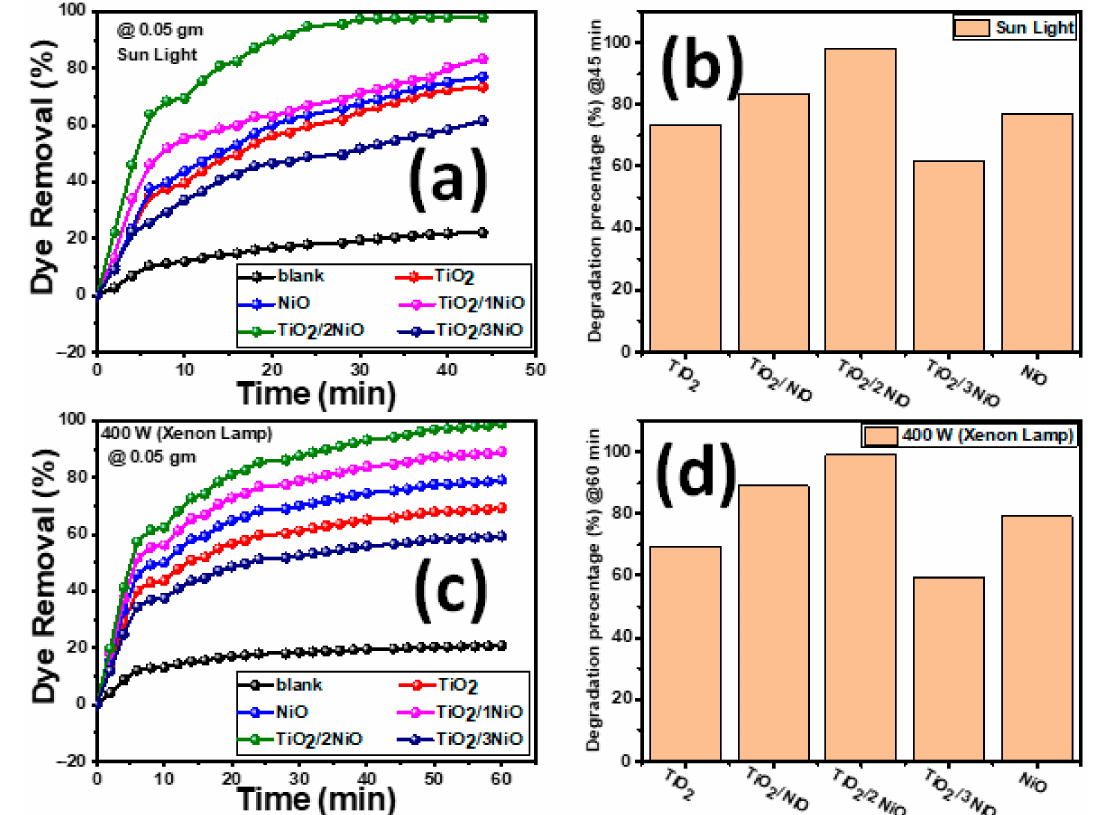
Figure 6. ( a ) The influence of sunlight illumination on the photodegradation of MB dye (5 mg/L) for all prepared nanopowder (0.05 g); ( b ) the degradation percentage of MB under sunlight irradiation for 45 min; ( c ) the effect of Xenon Lamp (400 W) irradiation on the photodegradation of MB dye (5 mg/L) for all fabricated nanopowder (0.05 g); and ( d ) the degradation percentage of MB under 400 W Xenon Lamp irradiation for 60